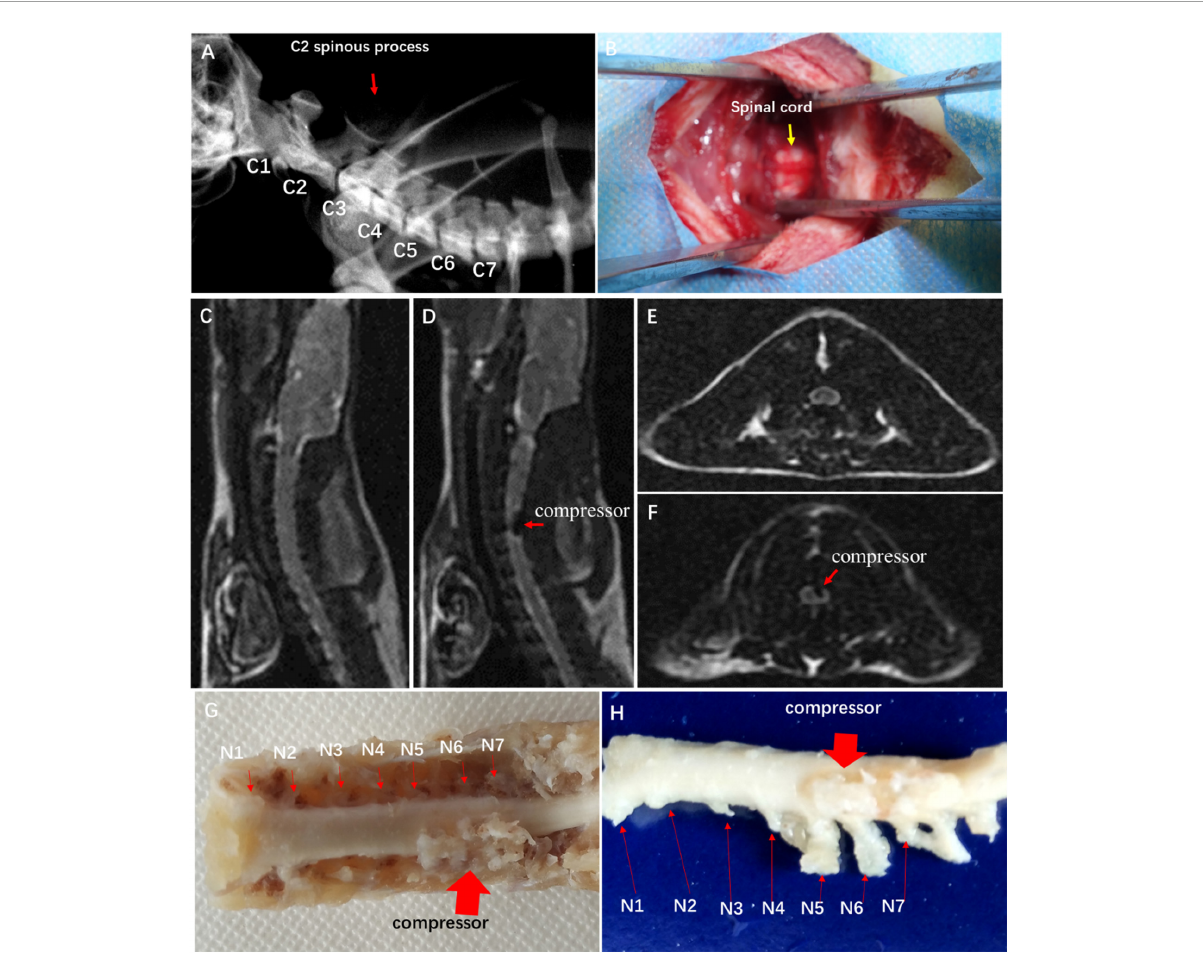
FIGURE1 Establishment of experimental CSM rat model. (A) Spine location in X-ray fluoroscopy. (B) Surgical exposure at C4 and C5 spinal levels. Sagittal MRI T2-weighted images of control group (C) and CSM group (D) . Axial MRI T2-weighted images of control group (E) and CSM group (F) . (G,H) View of specimen after